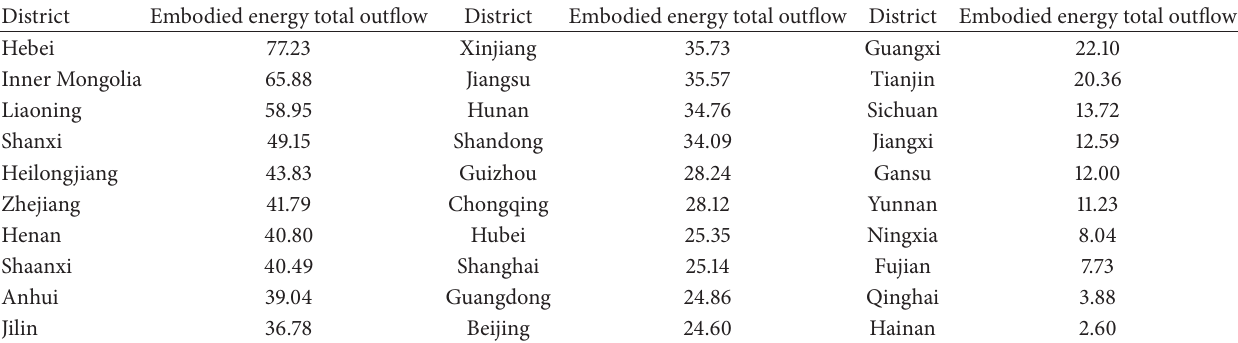
Table 3: Outflows of embodied energy via China’s interprovincial trade (in millions of tons of standard coal).